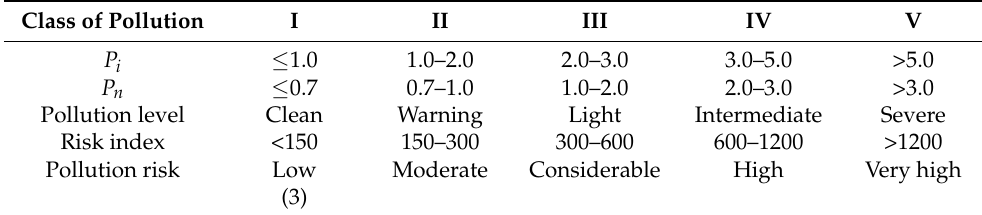
Table 1. The grading standards for pollution indices